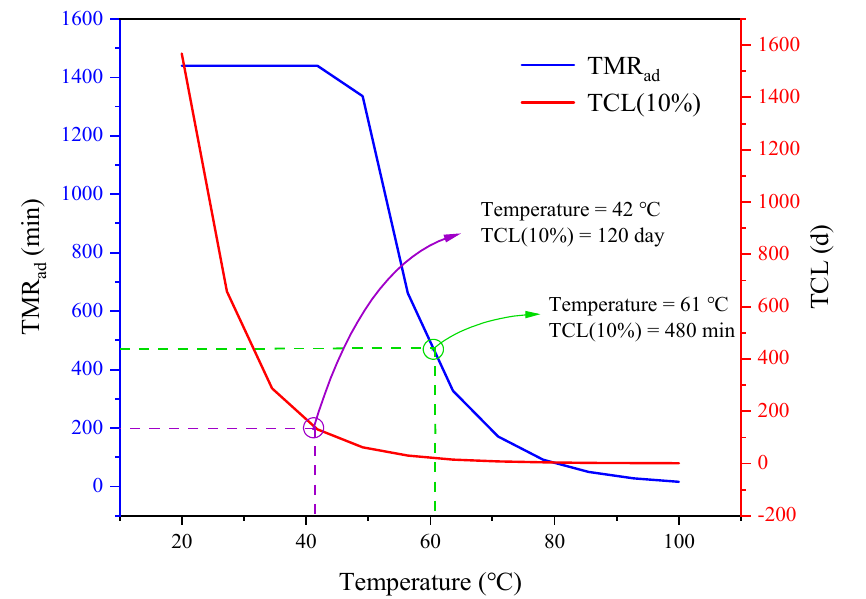
Figure 12. Time to conversion limit (TCL) and adiabatic time to maximum rate (TMR ad ) vs. temperature of PSS + (NH 4 ) 2 SO 4 .